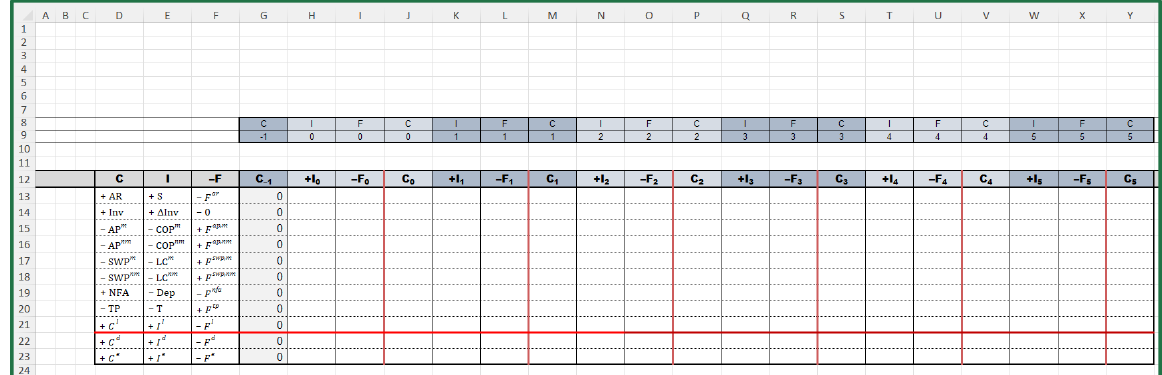
Figure 8. Structure of the full-scale strip in the spreadsheet (“SplitScreenStrip” sheet). The table has a first group of columns representing a generic full-scale SSM: column D, E, and F report, respectively, the capital amounts, incomes, and cash flows. 7 The following columns (from column G on) will contain the figures of the project, starting from period t = − 1, before the beginning of the project. The total number of columns containing numerical values is ( 3 · ( n + 1 ) + 1 ) . Each value is 0 in column G since the project has not started yet ( C − 1 = 0).